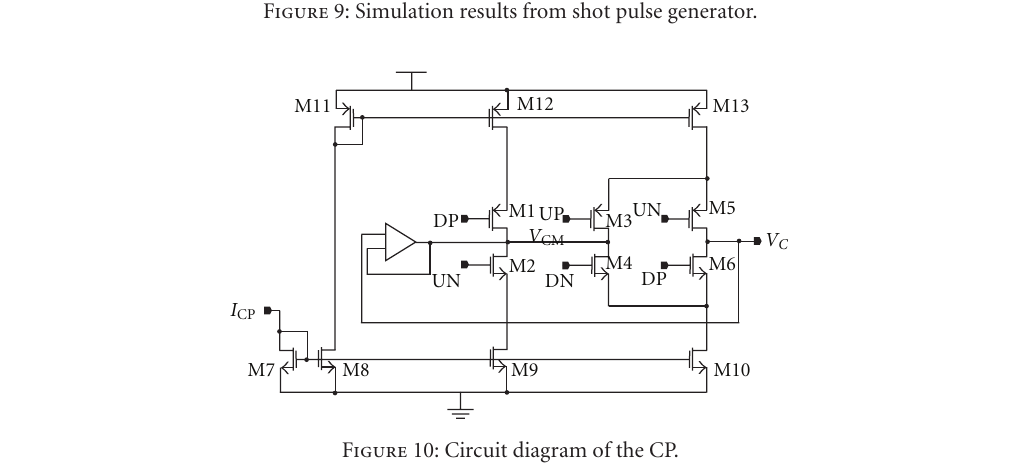
Figure 9: Simulation results from shot pulse generator.